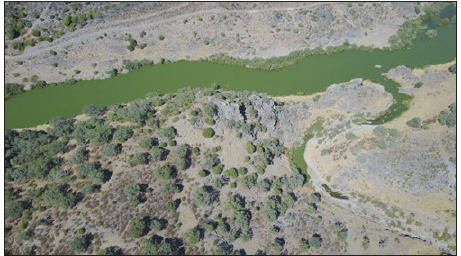
Figure 9: View of the site of Castelo Velho de Safara, Portugal (Photo: Mariana